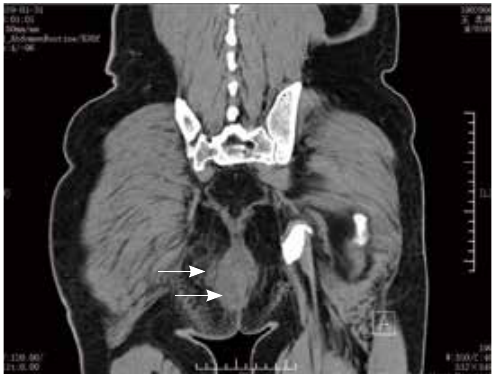
Figure 5 TRUS image at sagittal view at about 9~10 o’clock shown the anechoic lesion separated from the abscess.